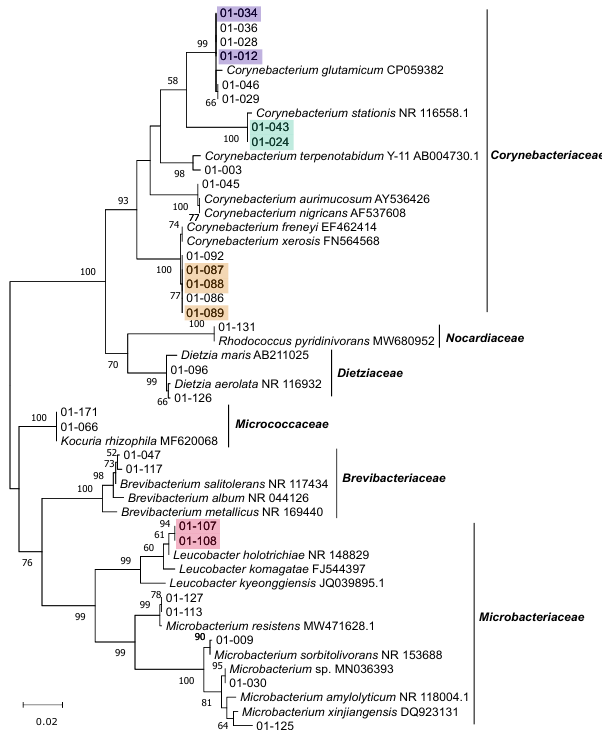
Figure 4. Unrooted maximum-likelihood tree of isolates belonging to the phylum Actinobacteria , shown, along with the closest related type strains and other relevant strains. Phylogenetic analysis was based on the unambiguous alignment (1274 sequence positions) of 16S rRNA gene sequences. GenBank accession numbers are included. Numbers at nodes indicate bootstrap values, based on 1000 replications. Identical isolates based on fingerprinting results (see Supplementary Figure S1) are marked with the same color.